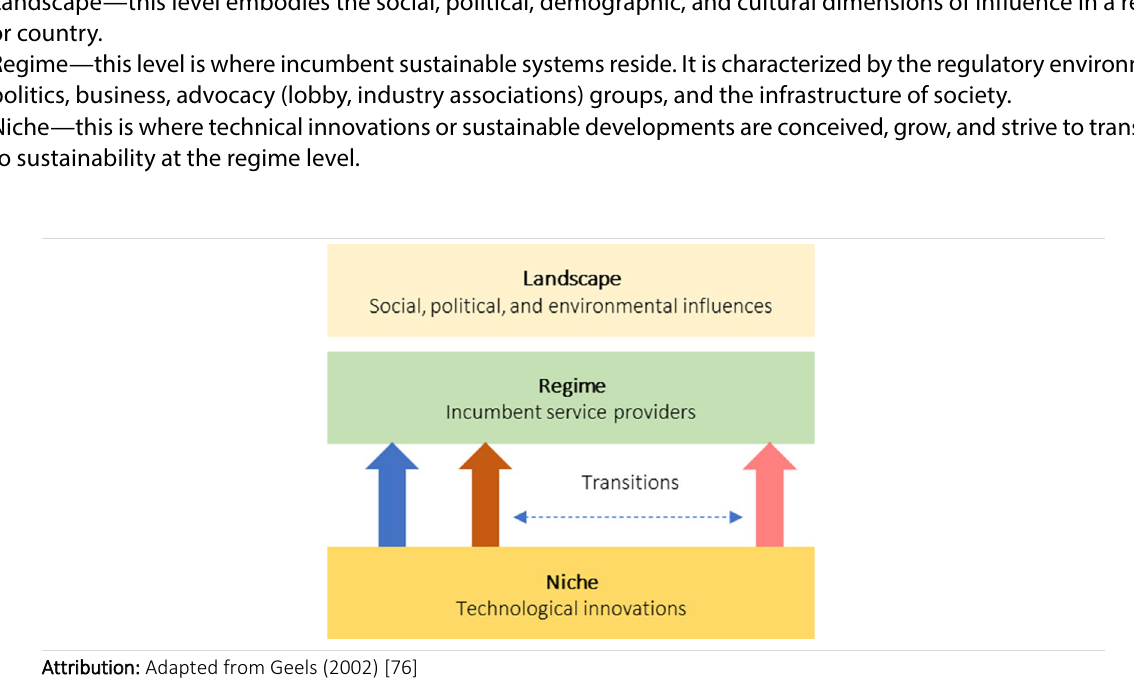
Fig. 6 Multiple-Level Perspectives of STTT for Poverty